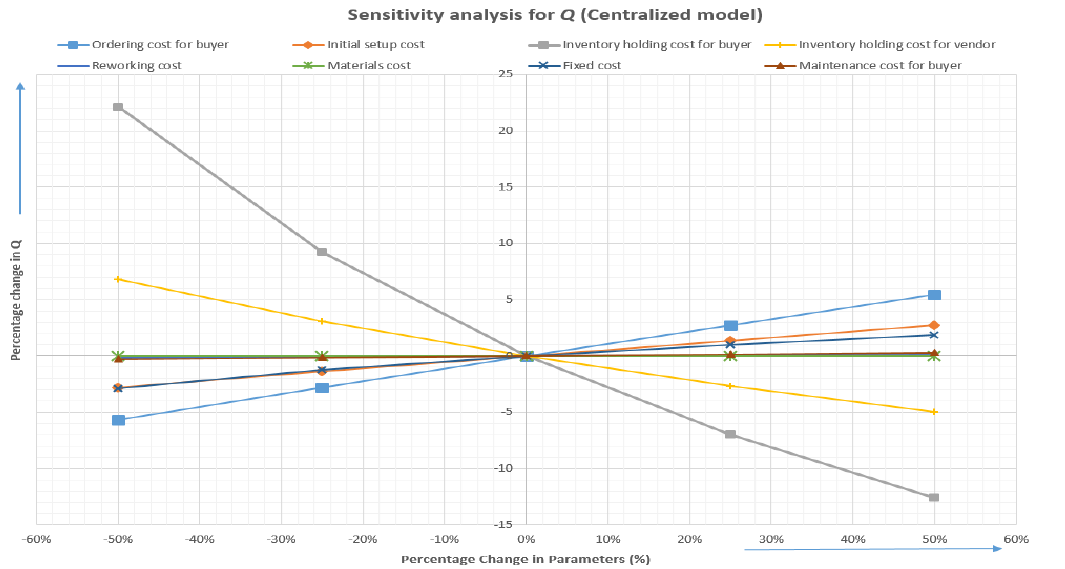
Figure 9. Sensitivity analysis: total cost versus change in parameters under centralized